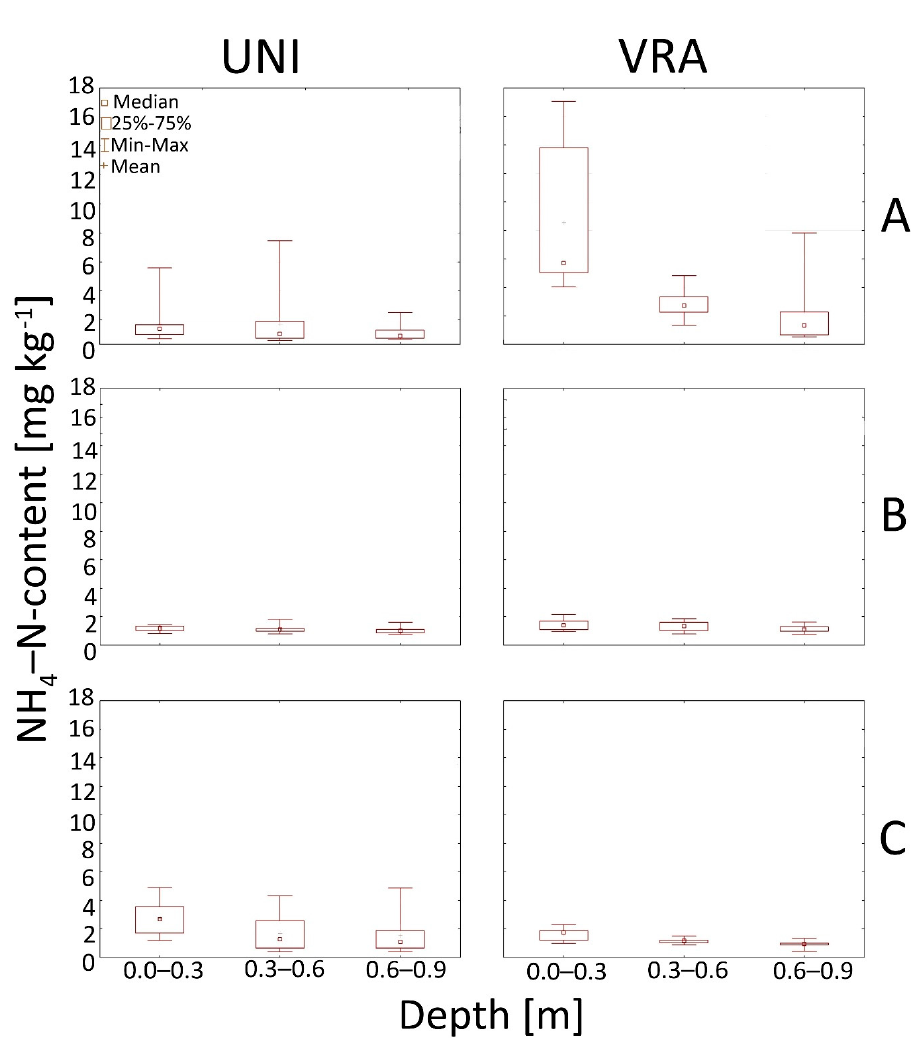
Figure 5. Box and whiskers plots presenting the ammonium content in the soil after UNI and VRA fertilization at the analyzed experimental sites A, B, and C. ( A – C ).